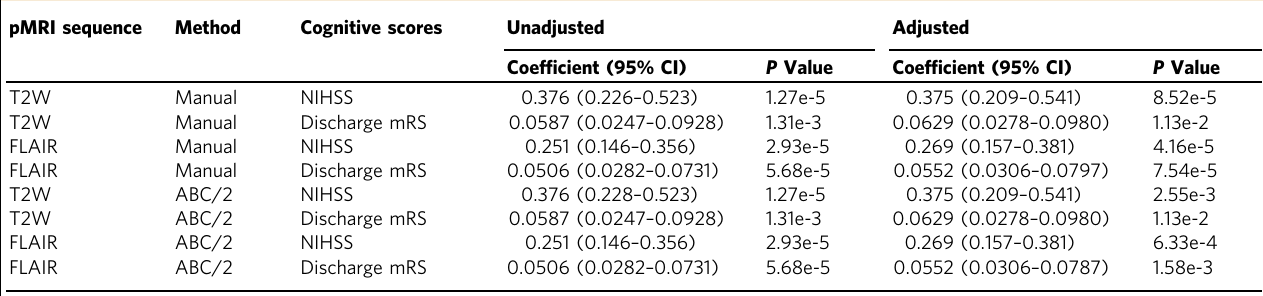
Table 3 Portable MRI hematoma volume and patient cognitive scores. pMRI